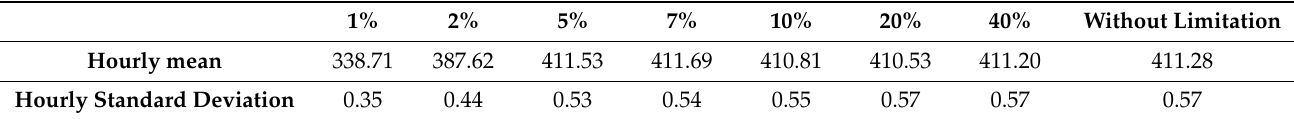
Table 5. Hourly mean and hourly standard deviations of the power in kW produced with and without limits.